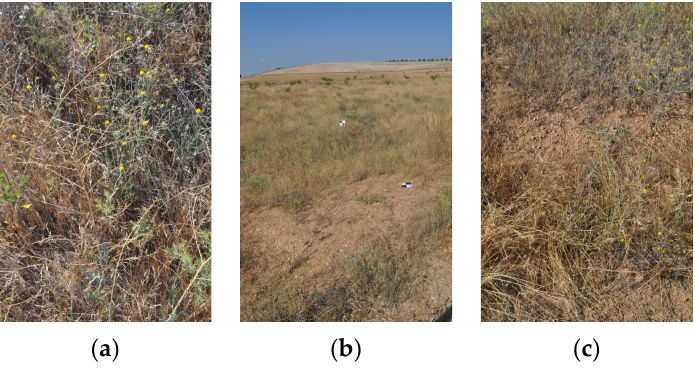
Figure 4. ( a – c ) Swales and natural corridors vegetation—author’s photo 07/2022 (MM/YYYY).